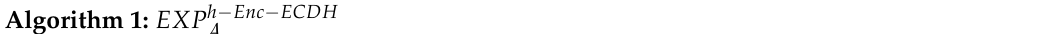
Algorithm 1: EXP h − Enc − ECDH